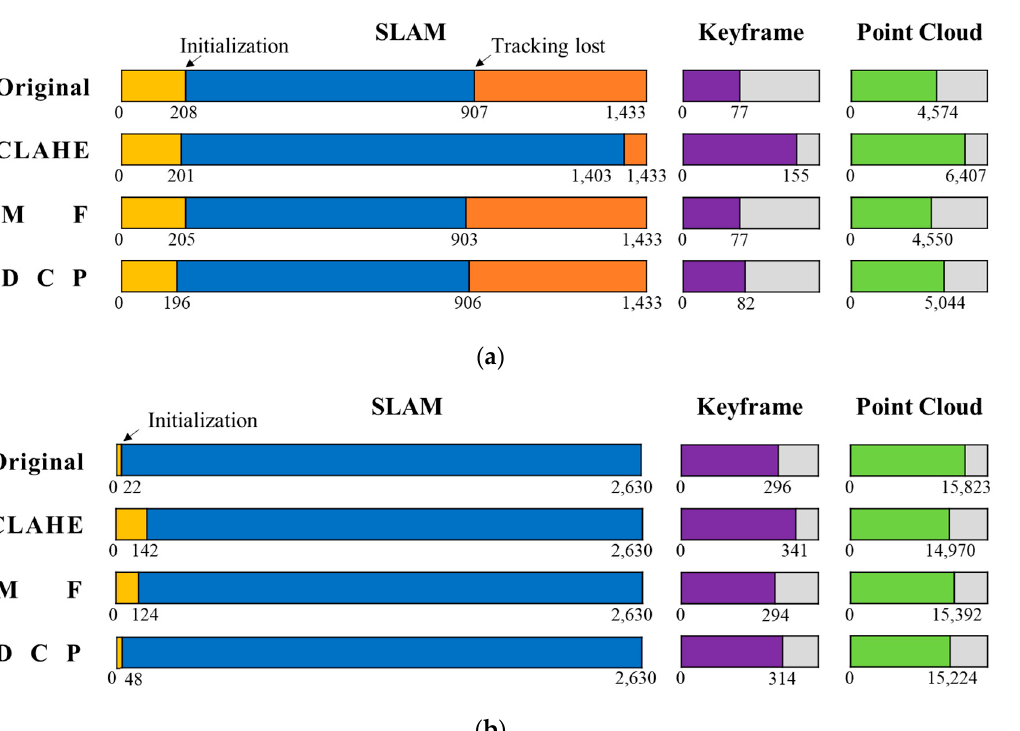
tracking lost. The CLAHE obtained the most keyframes and the least point clouds.